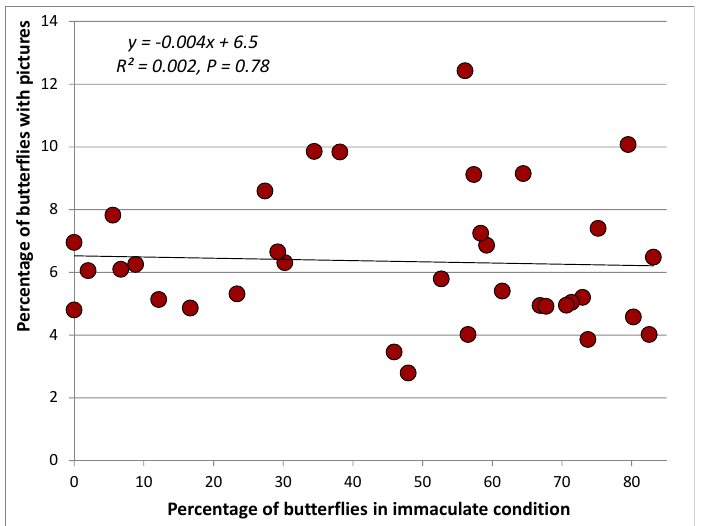
Figure A6. Relation between the condition of peacock butterflies in Belgium by week (weeks 10–44) and the proportion of records with pictures submitted in that week.